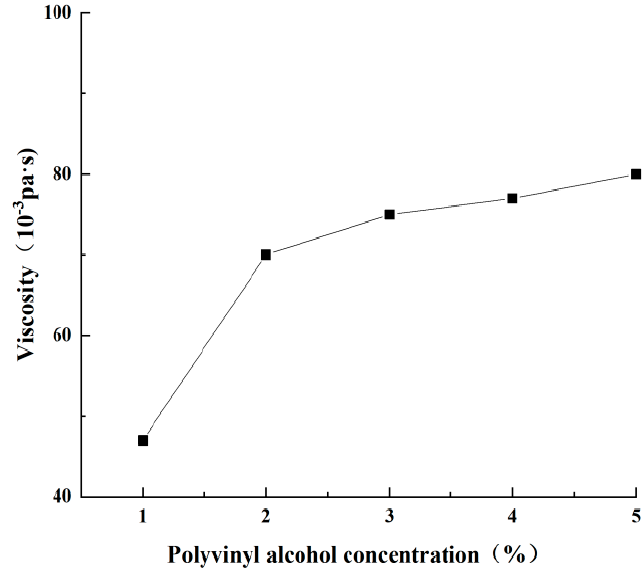
Figure 9. Effect of polyvinyl alcohol concentration on the slurry viscosity.